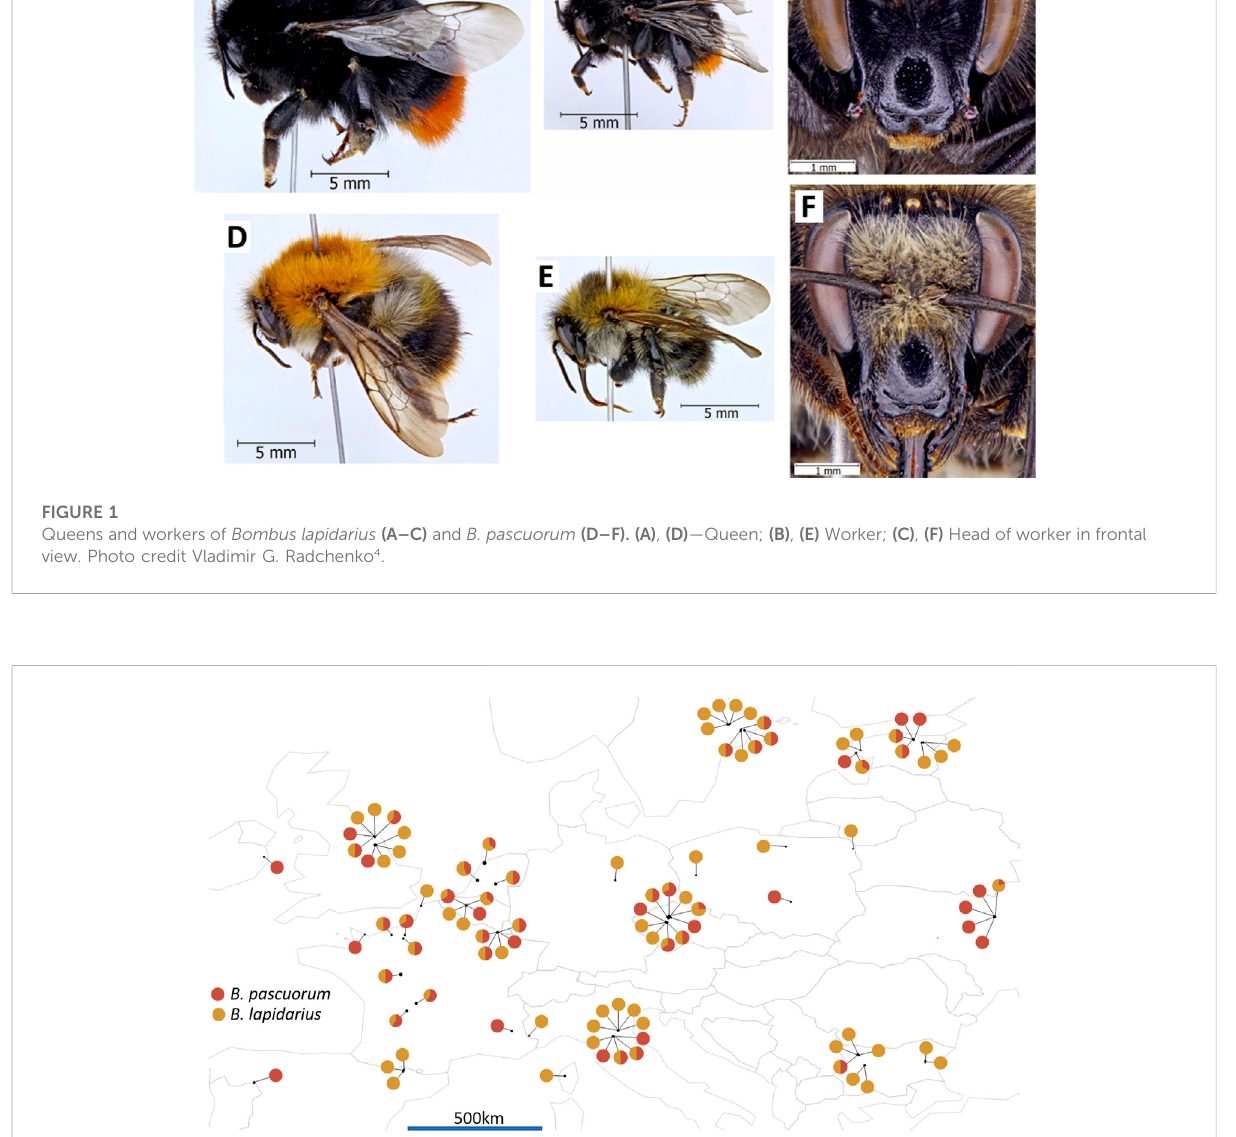
Filters (Merck Millipore, Belgium). Excess RNA was apparent when the DNA quality was visually assessed using agarose gels, so samples were treated with 1 µl of RNAse A (Thermo Fisher Scienti fi c, Belgium) at 2 mg/ml per 20 – 30 µg of DNA.